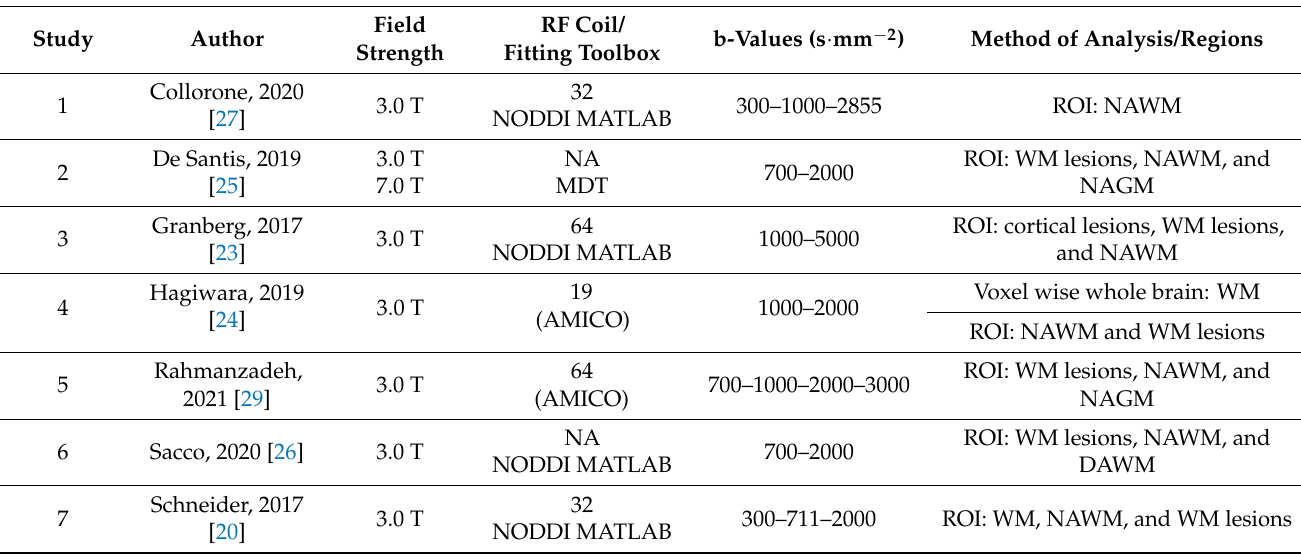
Table 2. Technical characteristics of included studies. Abbreviations: NA = not available; T = tesla; ROI = region of interest; NAWM = normal-appearing white matter; DAWM = dirty-appearing white matter; NAGM = normal-appearing grey matter; WM = white matter; RF = radiofrequency; and s · mm − 2 = second per